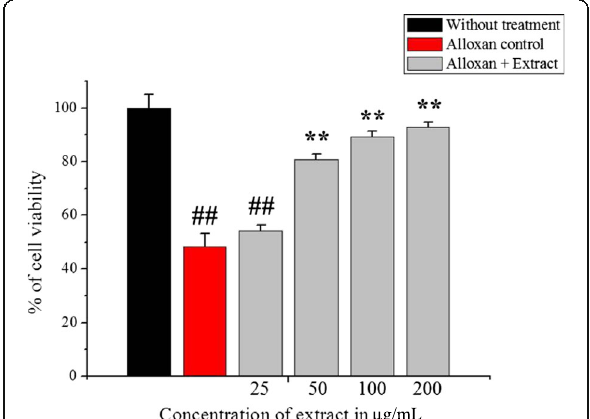
Fig. 4 Protective effect of C. crepidioides extract on alloxan induced cell cytotoxicity in INS-1 cells. Values were represented as mean ± SD ( n = 4). ## p < 0.01 as compared with the control group; ** p < 0.01 as compared with the alloxan control group. Toxicity results of INS-1 cell line induced with 200 μ M of alloxan and preincubated with different concentrations of